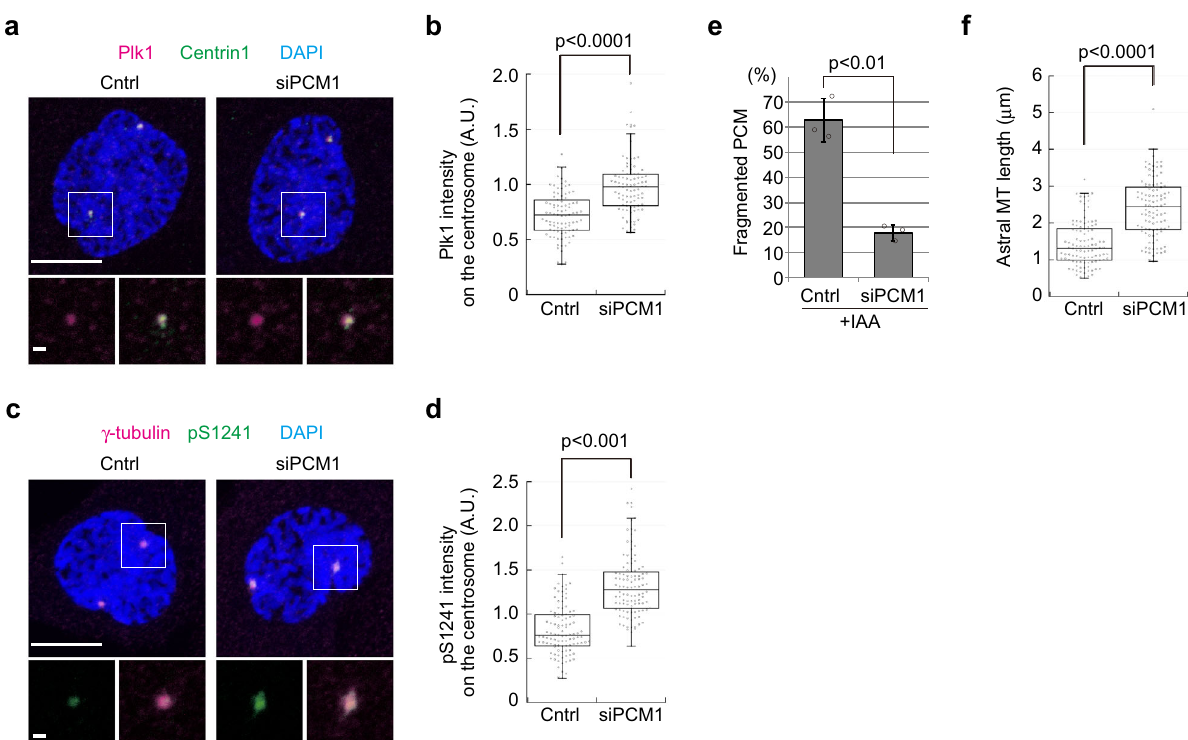
Fig. 7 Accumulation of PCM1 around centrosomes perturbs centrosomal Plk1 recruitment and PCNT phosphorylation in CENP-E KO. a , b CENP-E-AID cells were synchronized with thymidine for 22 h. In the fi rst 8 h of the synchronization, cells were treated with control siRNA or siPCM1. The cells were then released for 8 h with IAA, fi xed, and co-immunostained with antibodies against Plk1 (magenta) and centrin1 (green). Representative images for prophase cells in each sample are shown ( a , scale bar = 10 μ m). The area enclosed by the square in each image is magni fi ed and shown under the panel (scale bar